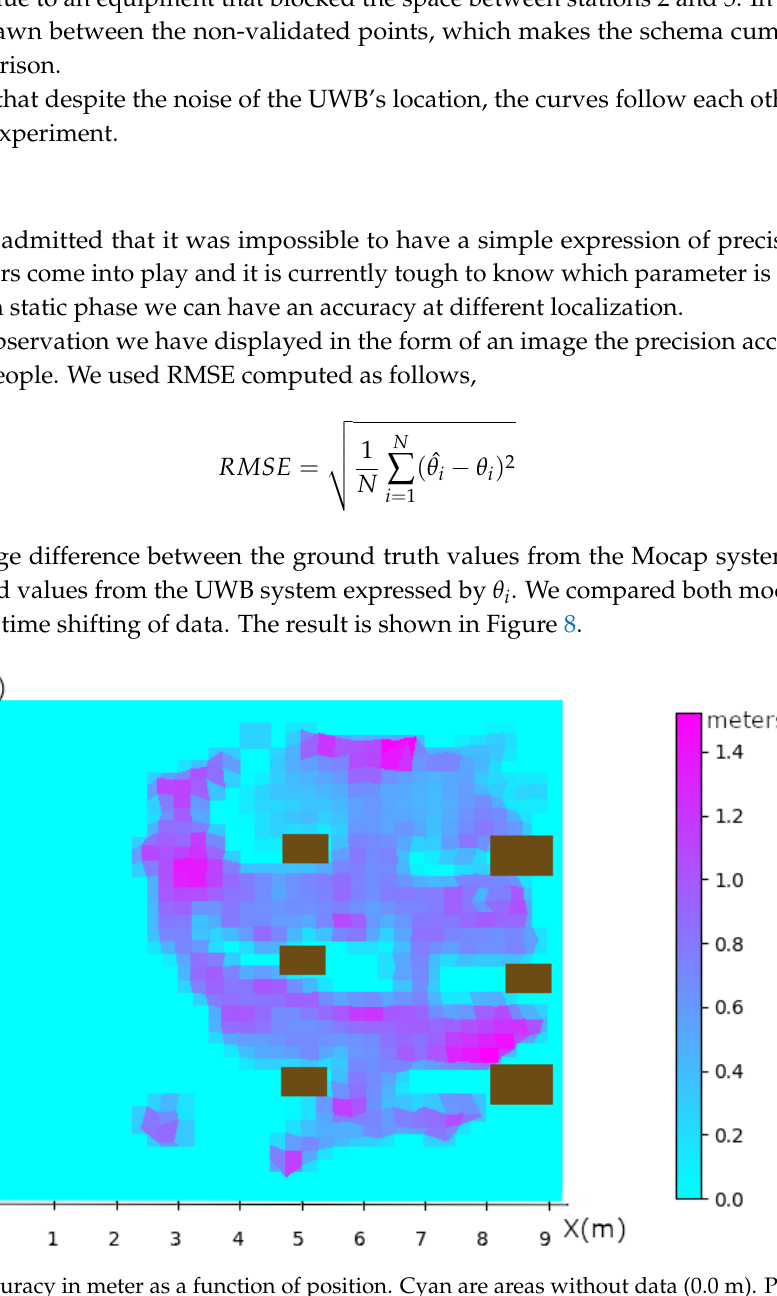
Figure 8. Accuracy in meter as a function of position. Cyan are areas without data (0.0 m). Purple are areas with a maximum error of 1.5 m. Brown rectangle are each